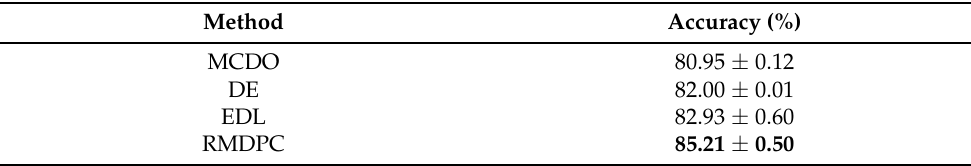
Table 4. Comparison with other uncertainty-based deep classification methods.